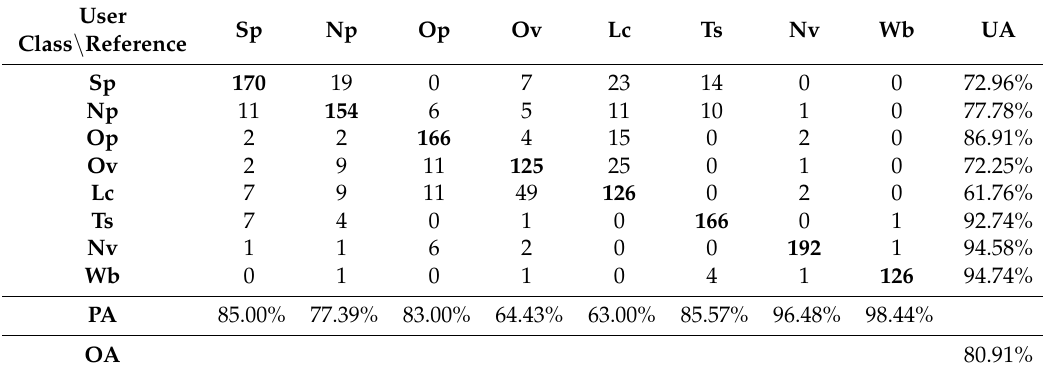
Table 5. Confusion matrices between classified image and reference data for the 26 important features. User